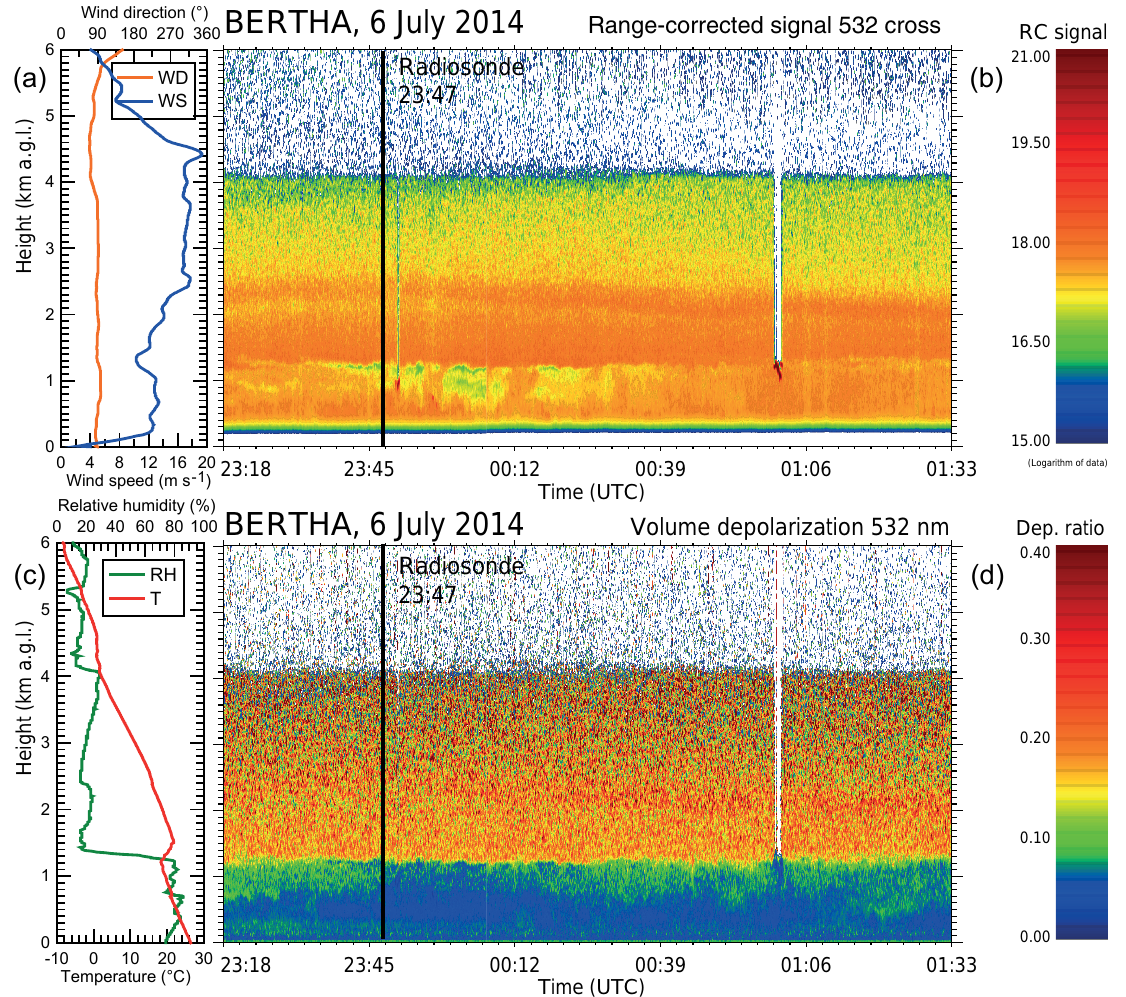
Figure 11. Saharan air layer (from 1.2 to 4.2km height) above the marine boundary layer. The same parameters as in Fig. 2 are shown. The lidar observation was performed on 6 July 2014, 19:18–21:33LT. The radiosonde was launched at 19:47LT (indicated by a black vertical line).